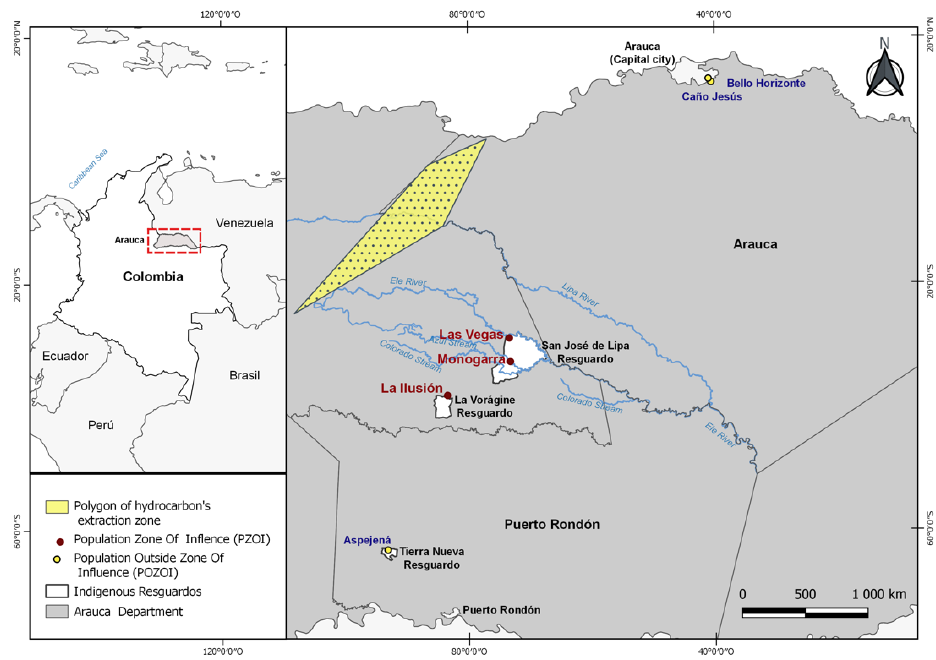
Figure 1. Location of Hitnü settlements in the study